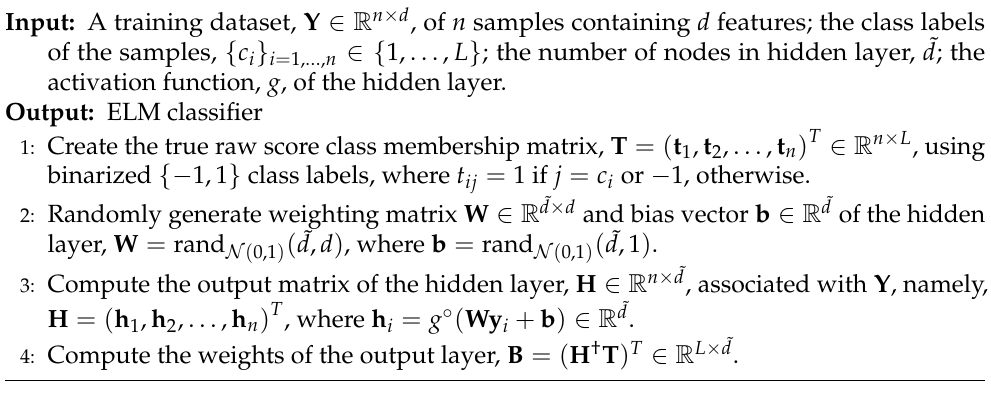
Algorithm A1. ELM neural network training for